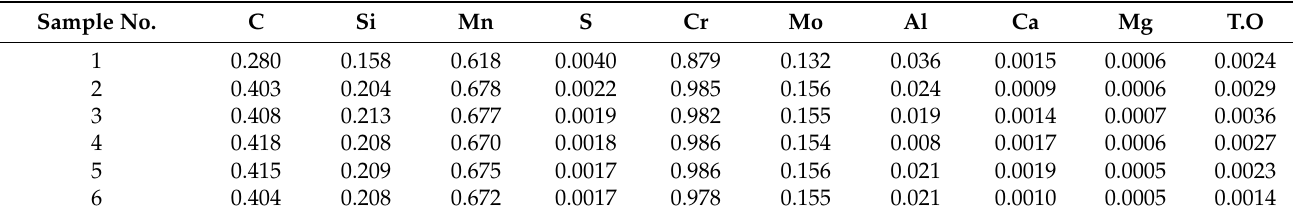
Table 1. Chemical compositions of 42CrMo4 steel (mass percent).